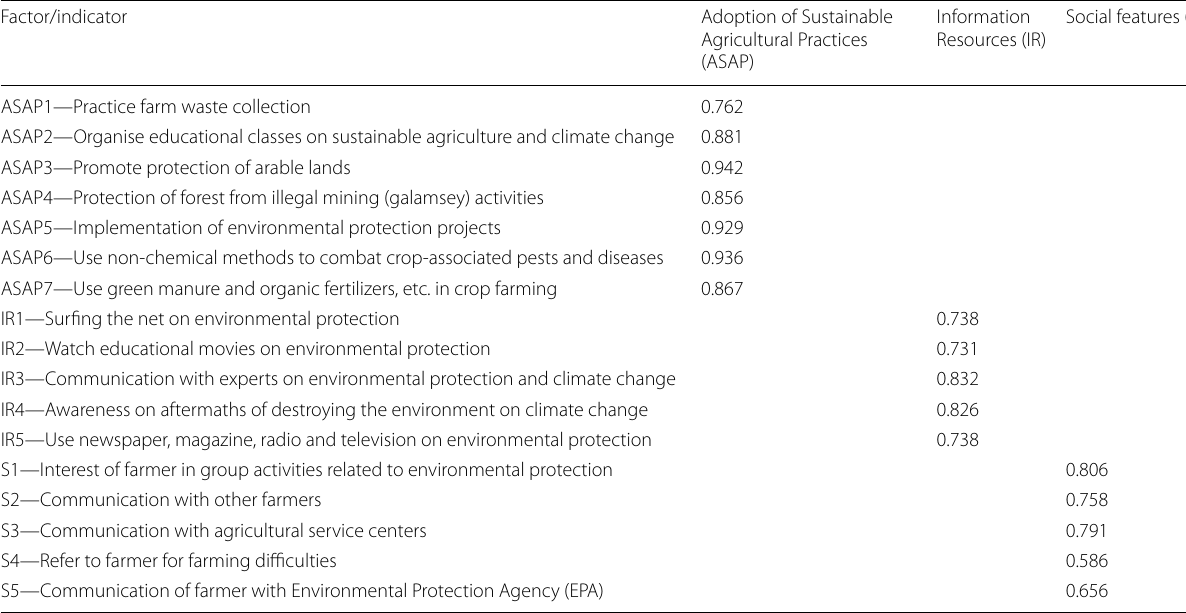
Table 5 Outer loadings of sustainable agriculture adoption factors